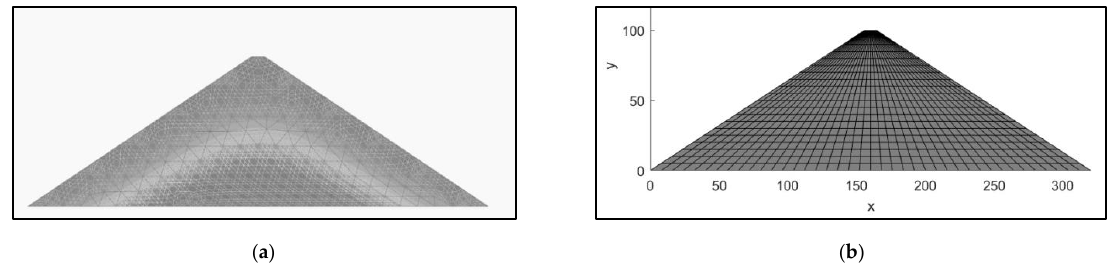
Figure 8. Mesh used ( a ) PLAXIS: 327 triangular elements with 15 nodes and ( b ) Matlab: 800 quadrilateral isoparametric bilinear quadrilateral elements (40 × 20) with 4 nodes.